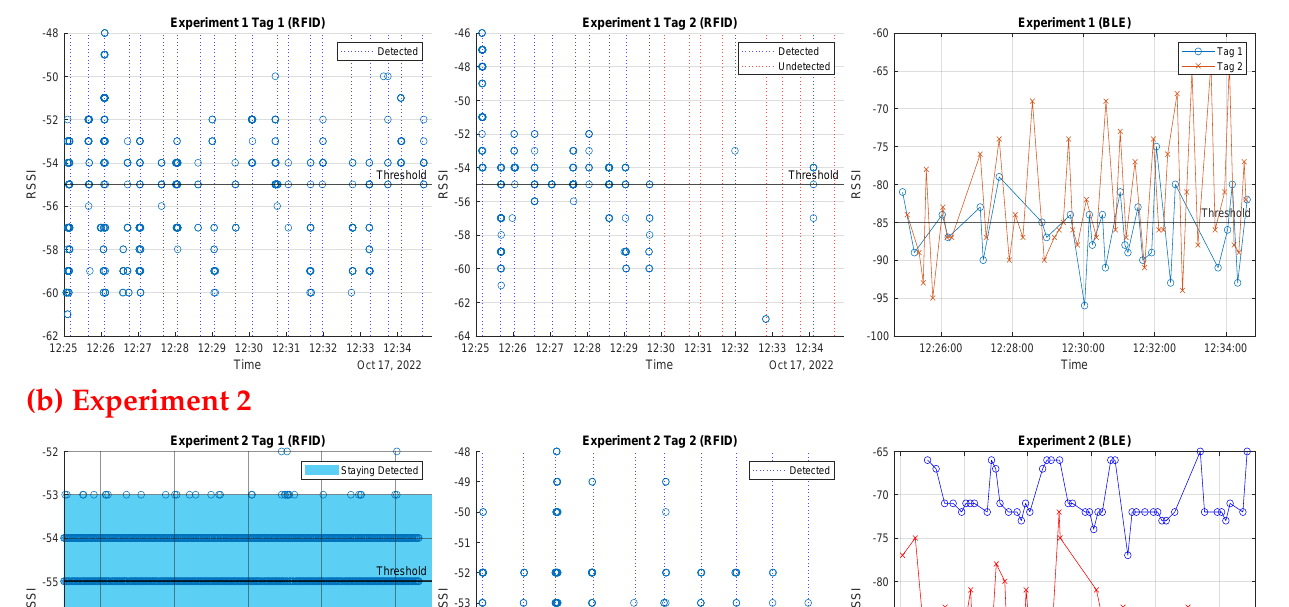
(a) Experiment 1 Experiment 1 Tag 1 (RFID)